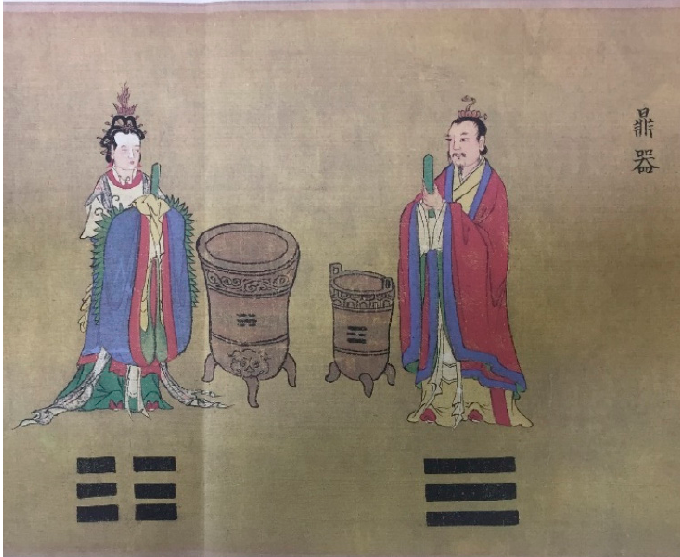
Figure 11. The diagram of the tripods found in the colored scroll version 34 .